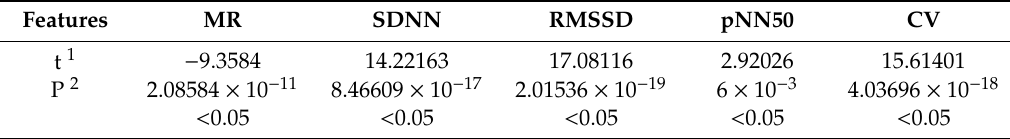
Table 6. Time-domain features by the student t-test.